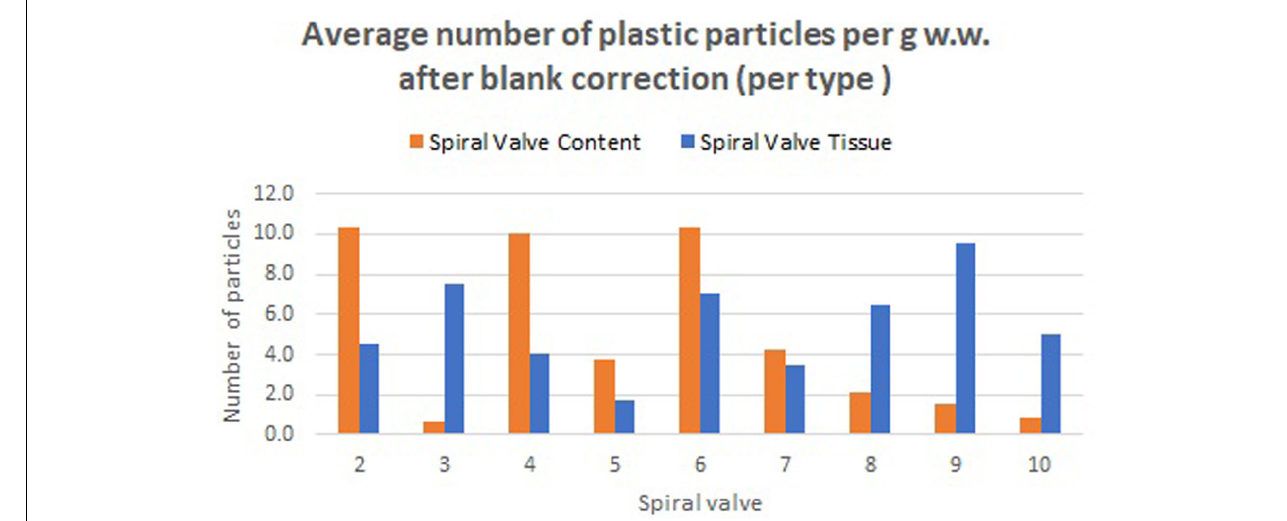
FIGURE 8 | Average number of plastic particles per g w.w. measured in spiral valve content and tissue after blank